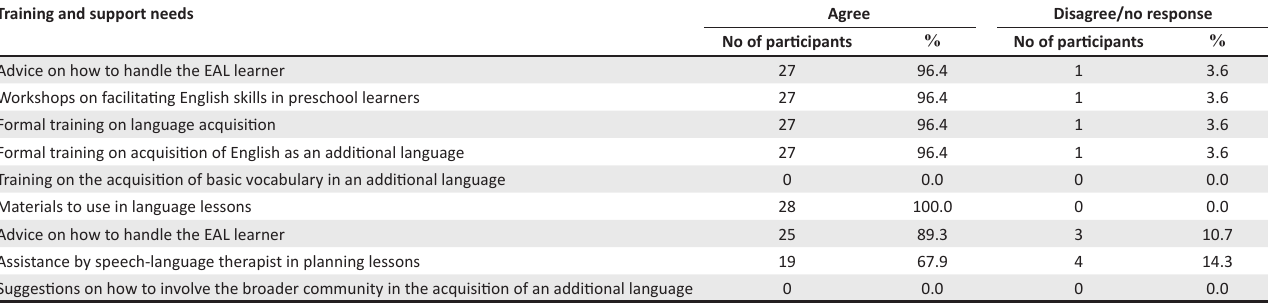
TABLE 2: Participants’ training needs: Quantitative strand ( n =